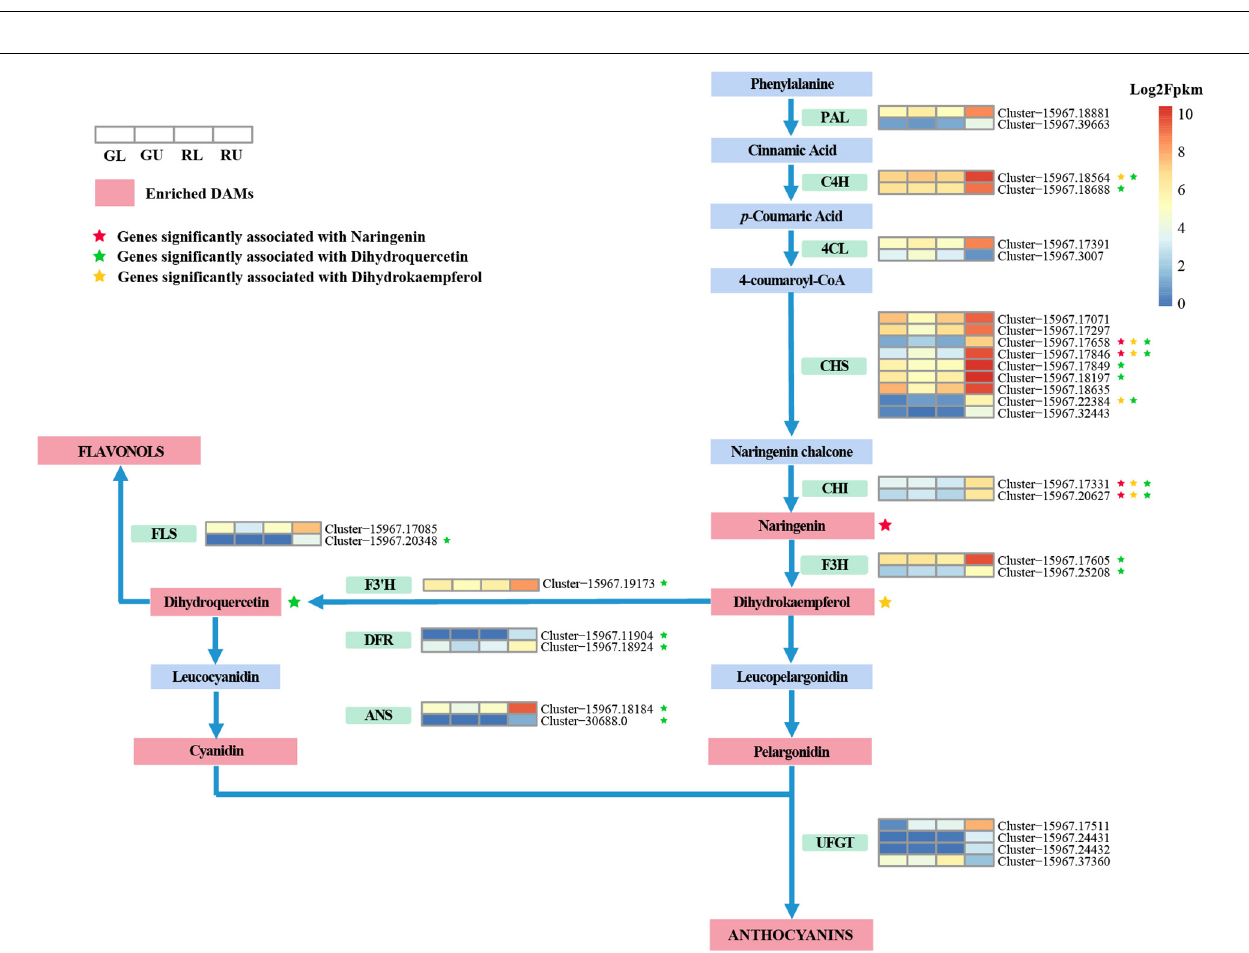
FIGURE 6 | Anthocyanin biosynthetic pathway in the young red leaves of H. hainanensis . Metabolites, in red boxes indicate the DAMs enriched in phenylpropanoid biosynthesis (ko00940), flavonoid biosynthesis (ko00941), and anthocyanin biosynthesis (ko00942) between RU vs. GU and RL vs. RU. Heatmaps represent DEGs enriched in anthocyanin biosynthesis pathway with | log2Fold Change| ≥ 2 in the comparison of RU vs. GU and RL vs. RU. Heatmaps are ordered by GL, GU, RL, and RU from left to right, with colors indicating the log2Fpkm relative expression. Colored stars indicate a significant correlation between an increase in metabolite accumulation and an increase in the expression of an associated gene. Enzyme abbreviations: PAL , phenylalanine ammonium lyase; C4H , cinnamate-4-hydroxylase; 4CL , 4-coumaroyl-CoA synthase; CHS , Chalcone synthase; CHI , chalcone isomerase; F3H , flavanone 3-hydroxylase; F3 (cid:48) H , flavonoid-3 (cid:48) -hydroxylase; DFR , dihydroflavonol 4-reductase; ANS , anthocyanidin synthase; UFGT , UDP-glucose flavonoid 3-O glucosyltransferase; FLS , flavonol synthase.